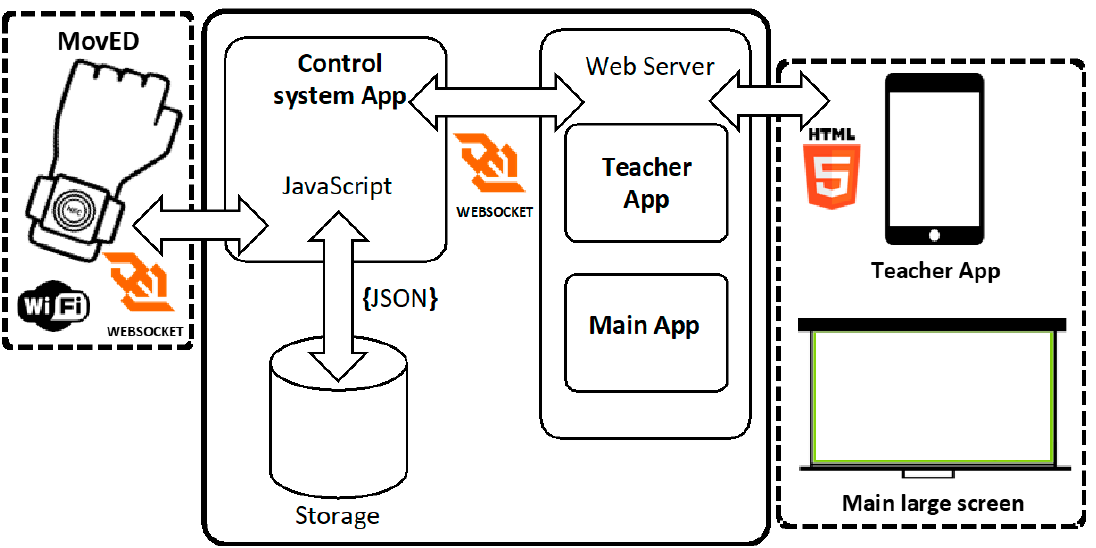
Figure 4. Activity Controller architecture.